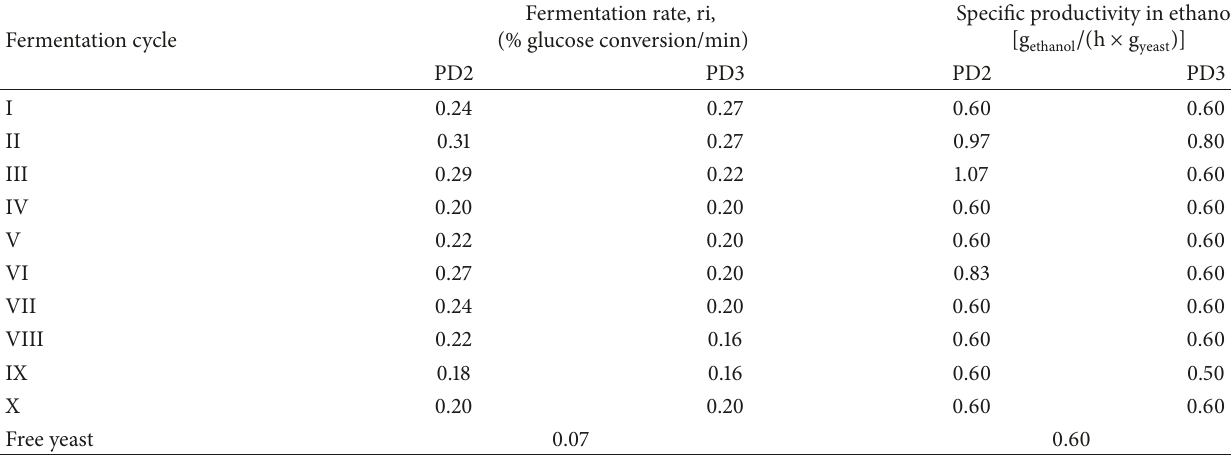
Table 8: Fermentation rate values and the specific ethanol productivity for samples PD2 and PD3 as a function of the fermentation cycle. Fermentation